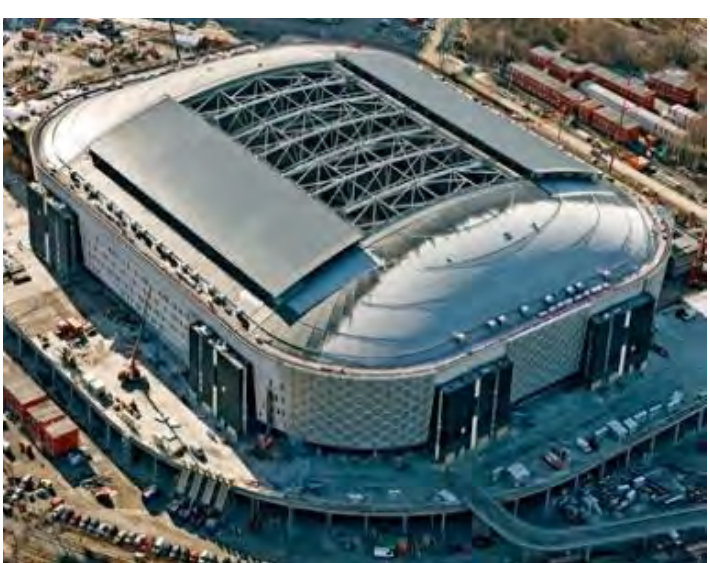
Figure 2. Swedbank